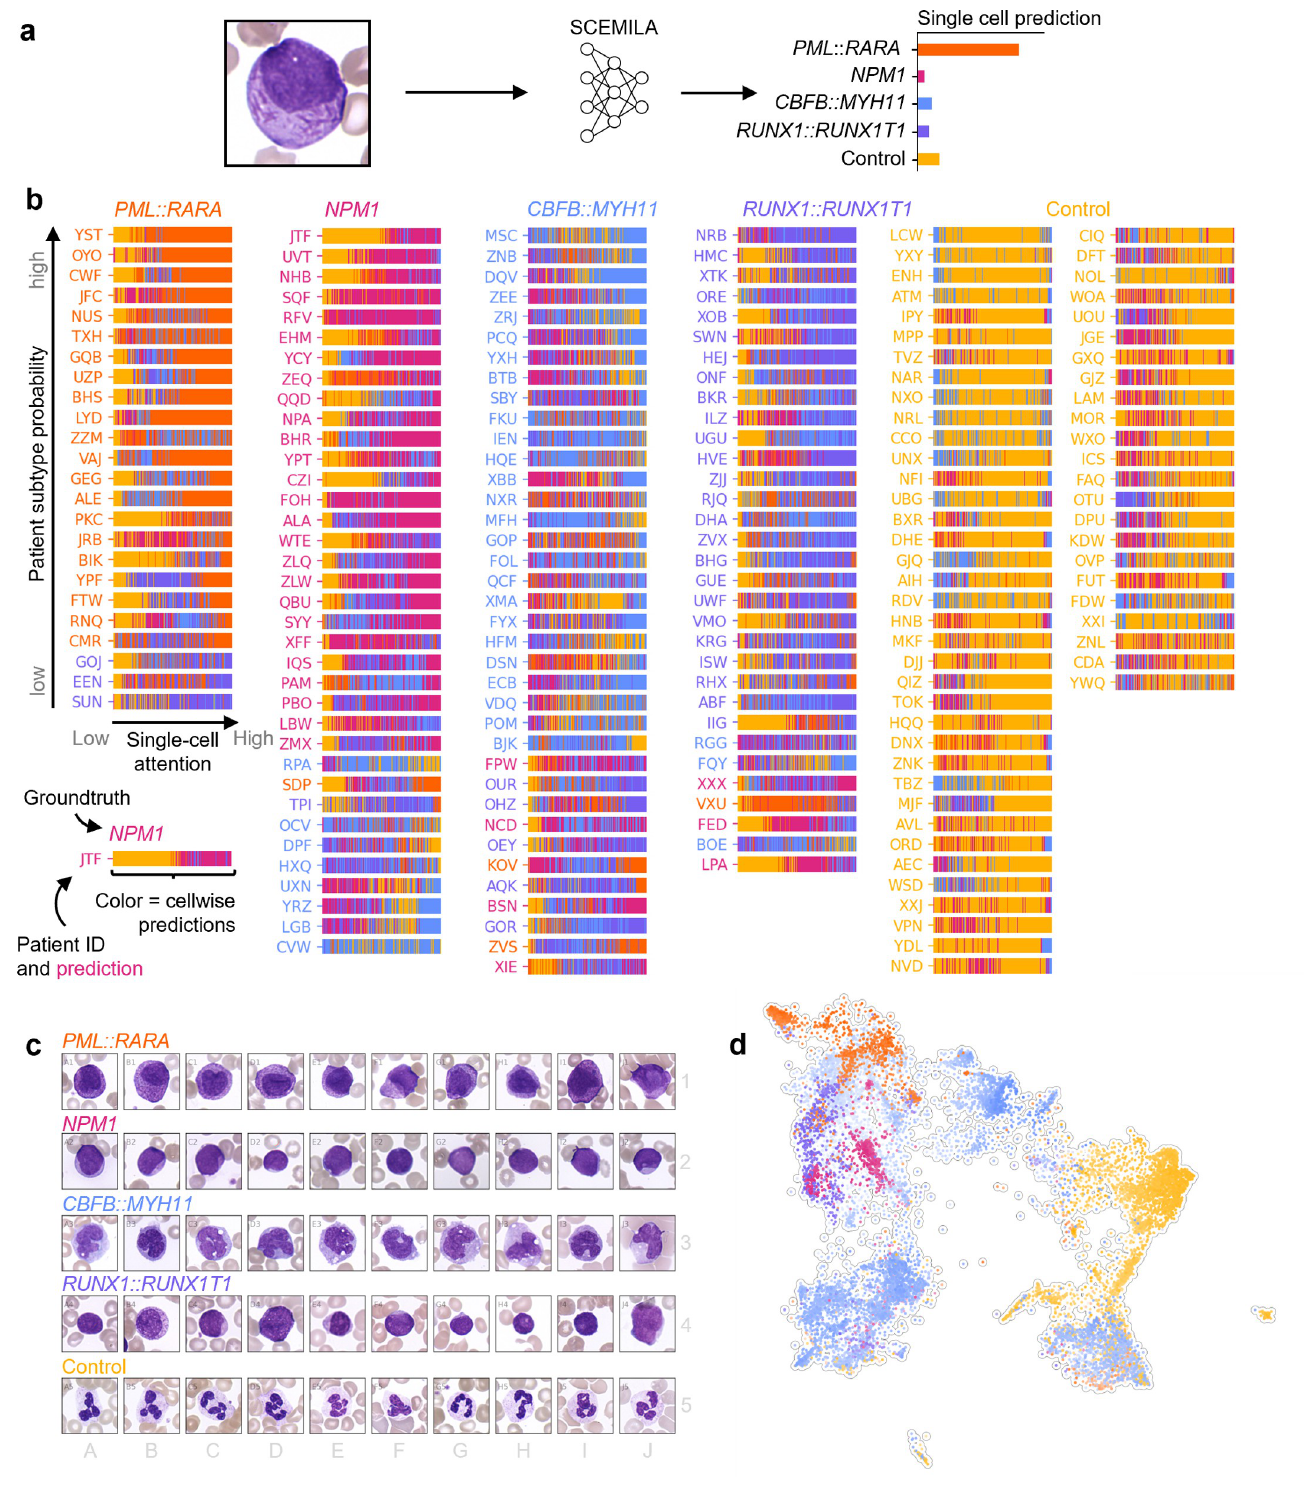
Fig 3. SCEMILA deconvolves patient composition and identifies representative cells for AML subtypes. (a) By passing instances individually through SCEMILA, the algorithm returns single cell predictions. (b) Bar plots show predictions for every single cell of each individual in our dataset. Cells are ordered by attention, with low-attention cells on the left and high-attention cells on the right side. Patients which were classified with strong output activation are presented further up in the list, and the corresponding bag prediction is encoded in the patient label color next to the column. (c) The top 10 cells (2 per fold, based on single